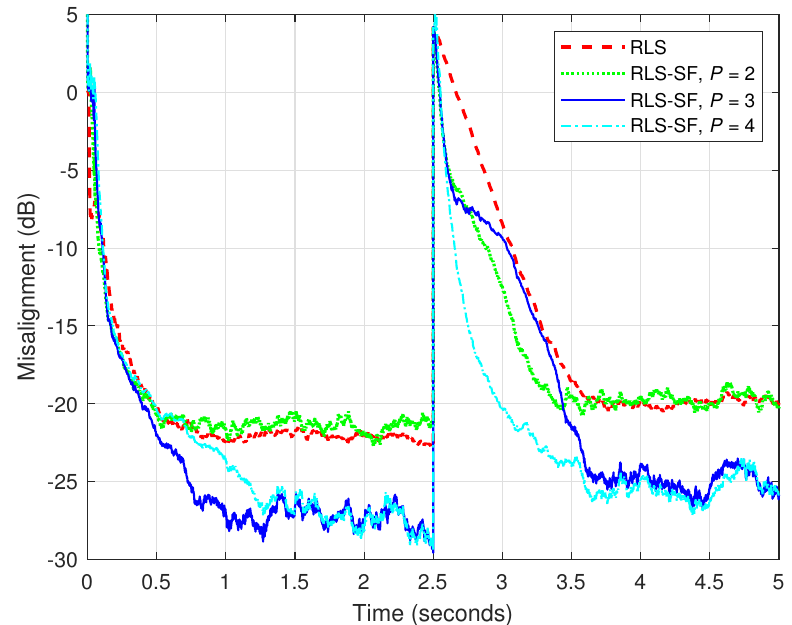
Figure 10. Performance of the conventional RLS filter [with λ = 1 − 1/ ( KL /2 ) ] and the RLS-SF [with λ 1 = 1 − 1/ ( 2 KPL 1 ) and λ 2 = 1 − 1/ ( 2 KPL 2 ) ], using K = 10, for the identification of the network echo paths from Figure 1a,b. The input signal is an AR(1) process, SNR = 20 dB, and the echo path changes after 2.5 s.